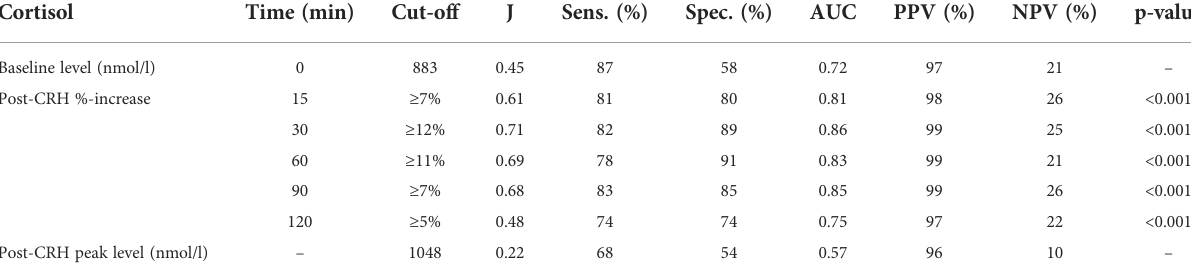
TABLE 3 Diagnostic outcome of cortisol during the CRH stimulation test.